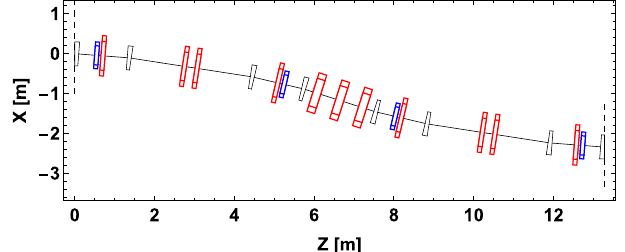
FIG. 7. Additional quadrupoles layout. Dipoles in black, quadrupoles in red and sextupoles in